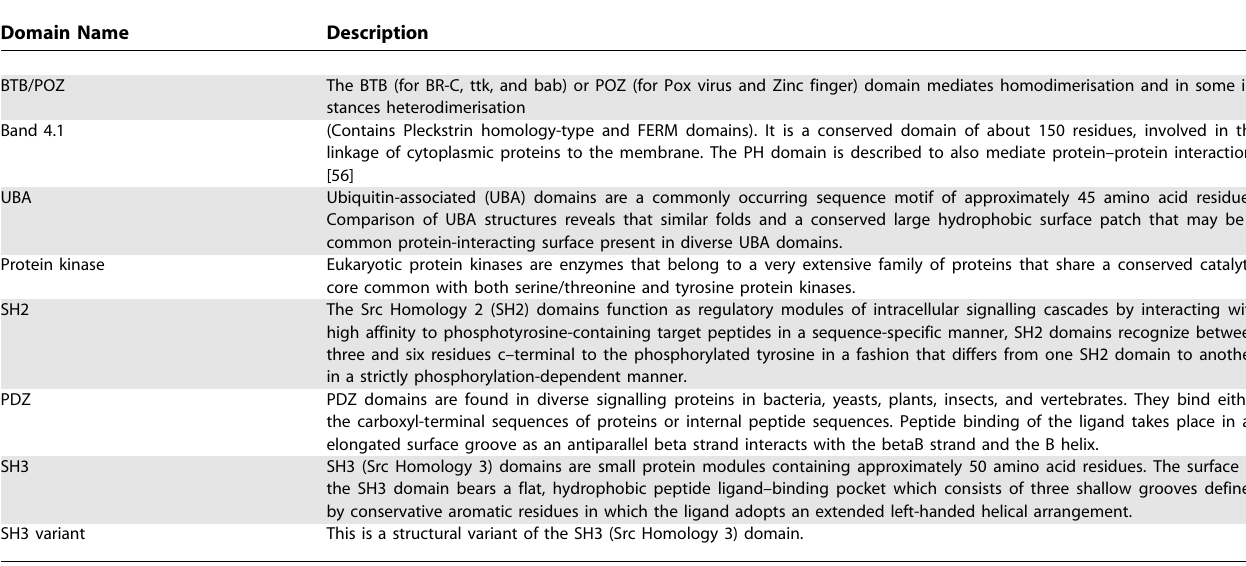
Table 2. Domains Found to Contribute to the Fast Rate of Change of Interactions in at Least Three of the Four Species Studied